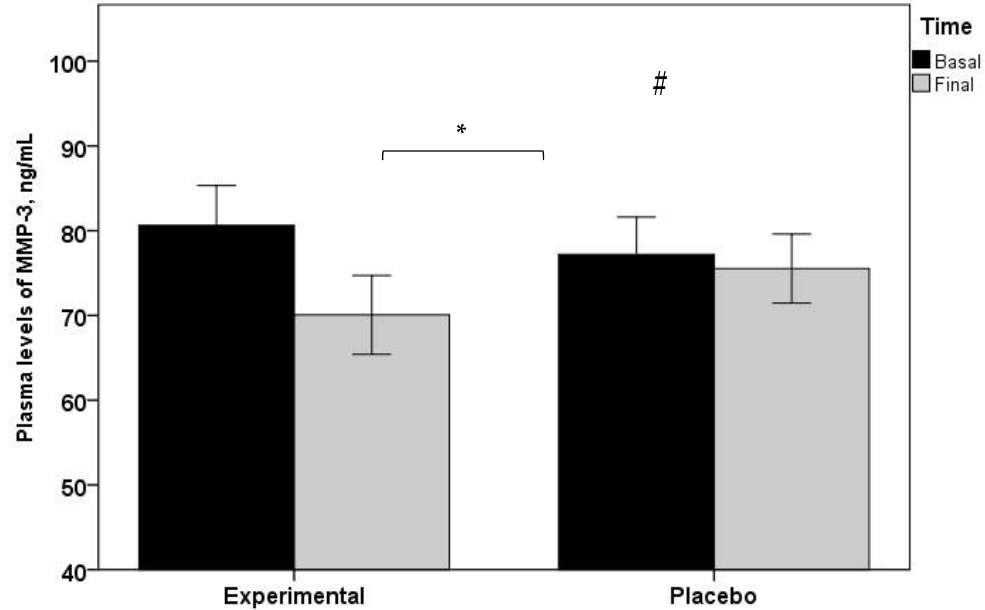
Figure 3. Changes in plasma levels of matrix metalloproteinase 3 (MMP-3) in the experimental (cucumber extract) and placebo groups at the final visit vs. baseline (bars = ±1 standard error); * p = 0.001; # p = 0.018.